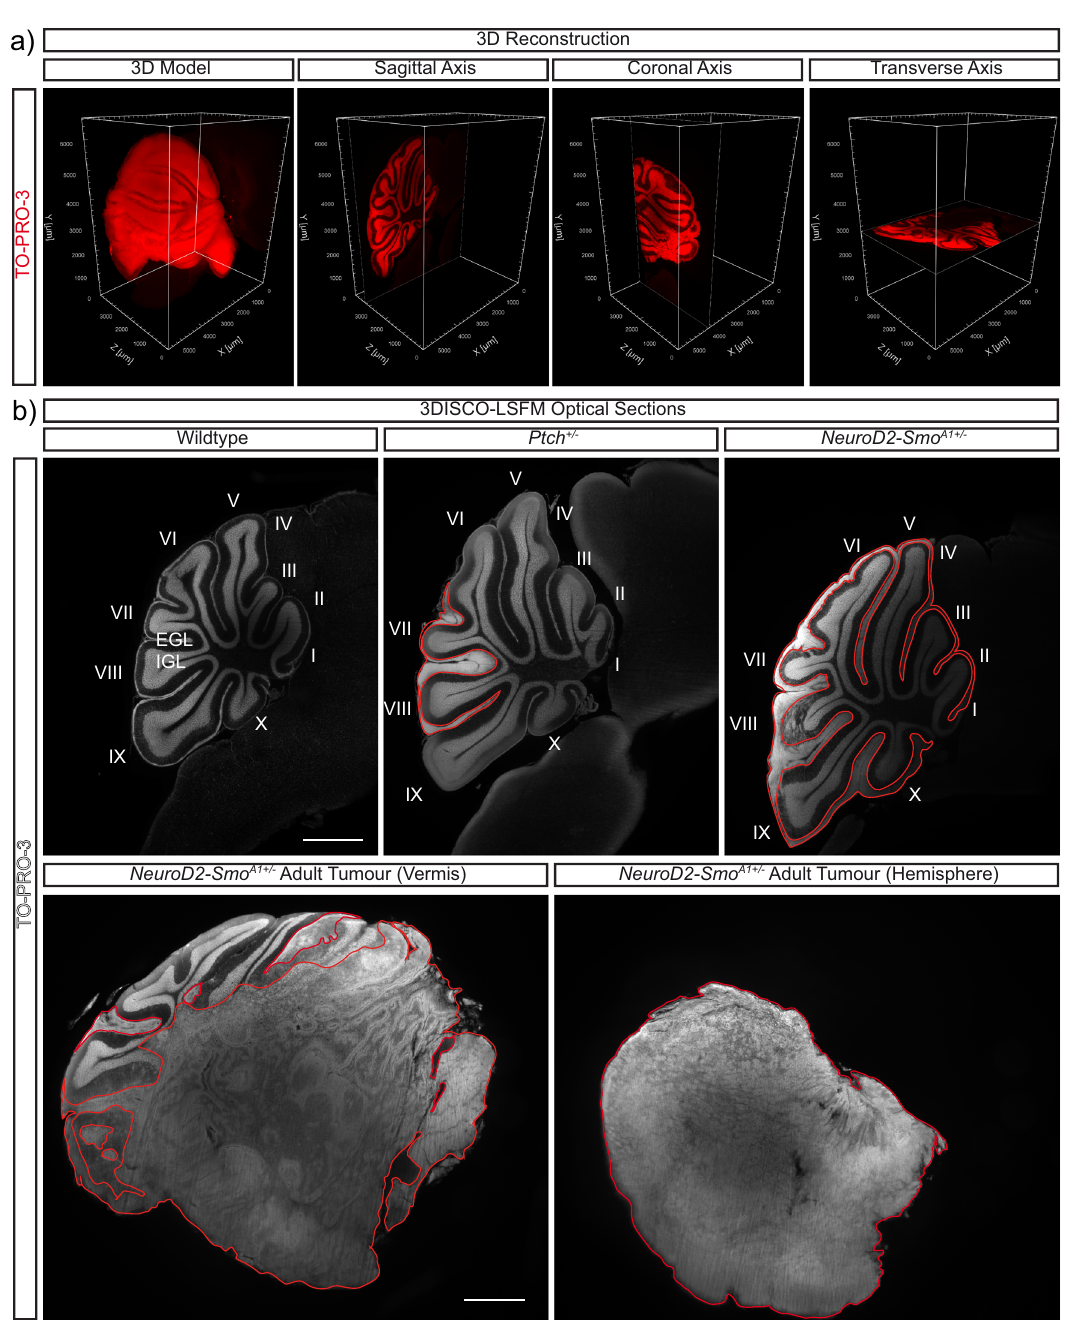
Fig. 1 Volumetric and cross-sectional visualization of stained and cleared cerebella. a TO-PRO-3 (red) stained cerebellar samples viewed as 3D reconstructions of optical sections in Imaris surpass view, or as single cross-sectional images in sagittal, coronal, and transverse axes. b TO-PRO-3 (white) stained cerebellar samples from P14 wildtype, Ptch + / − , Neurod2-Smo A1 + / − mice and a adult Neurod2-Smo A1 + / − mouse with a tumour. Outlined in red: an example of a PNL, hyperplastic EGL and tumour tissue in P14 Ptch + / − , P14 Neurod2-Smo A1 + / − and the Neurod2-Smo A1 + / − tumour samples, respectively. Cerebellar lobes (labelled I to X) are indicated in P14 samples, scale bar: 1000 µ